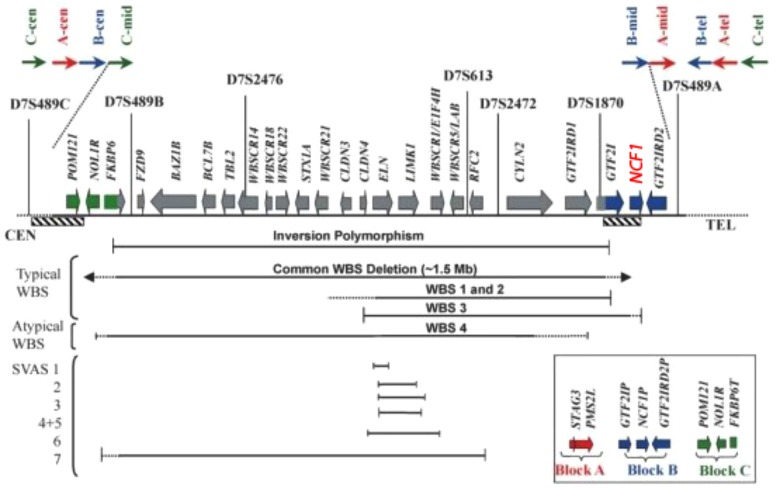
Transcript map of the Williams–Beuren syndrome critical region with the NCF1 gen (red) (Tassabehji, 2003).